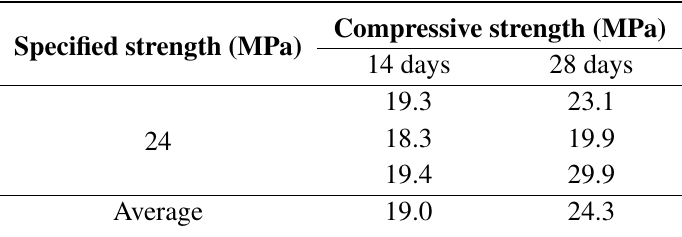
Table 2. Material properties of the